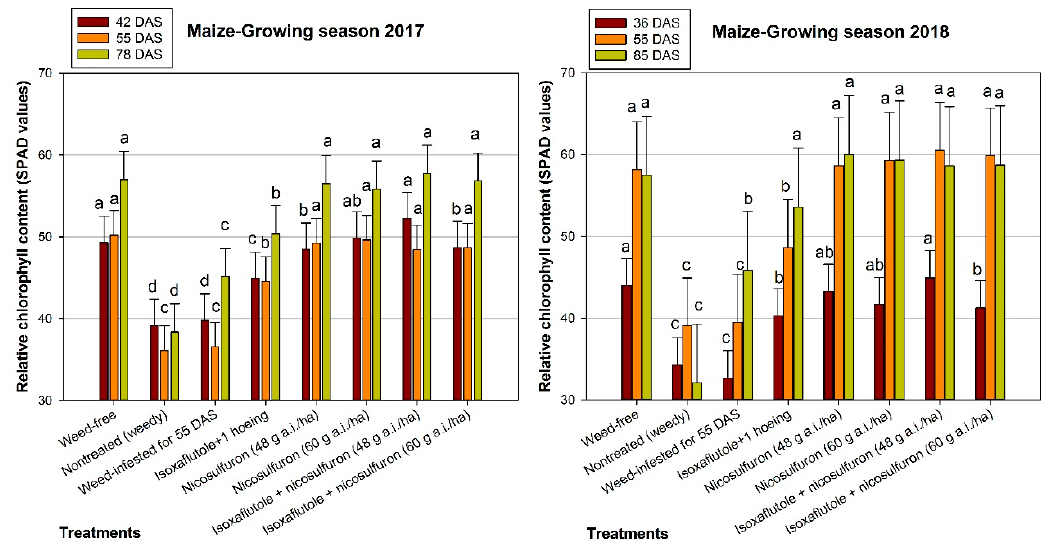
Figure 6. Maize relative chlorophyll content as affected by the various treatments at 36–42 days after sowing (DAS), 55 DAS, and 78–85 DAS, in 2017 and 2018 (Velestino, Greece). For each measurement, bars followed by different letters indicate significant differences according to Fisher’s LSD test ( p ≤ 0.05). Error bars indicate the LSD 5% values.